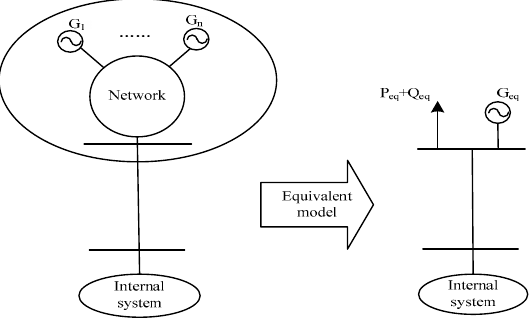
Figure 1. Dynamic equivalent model structure.